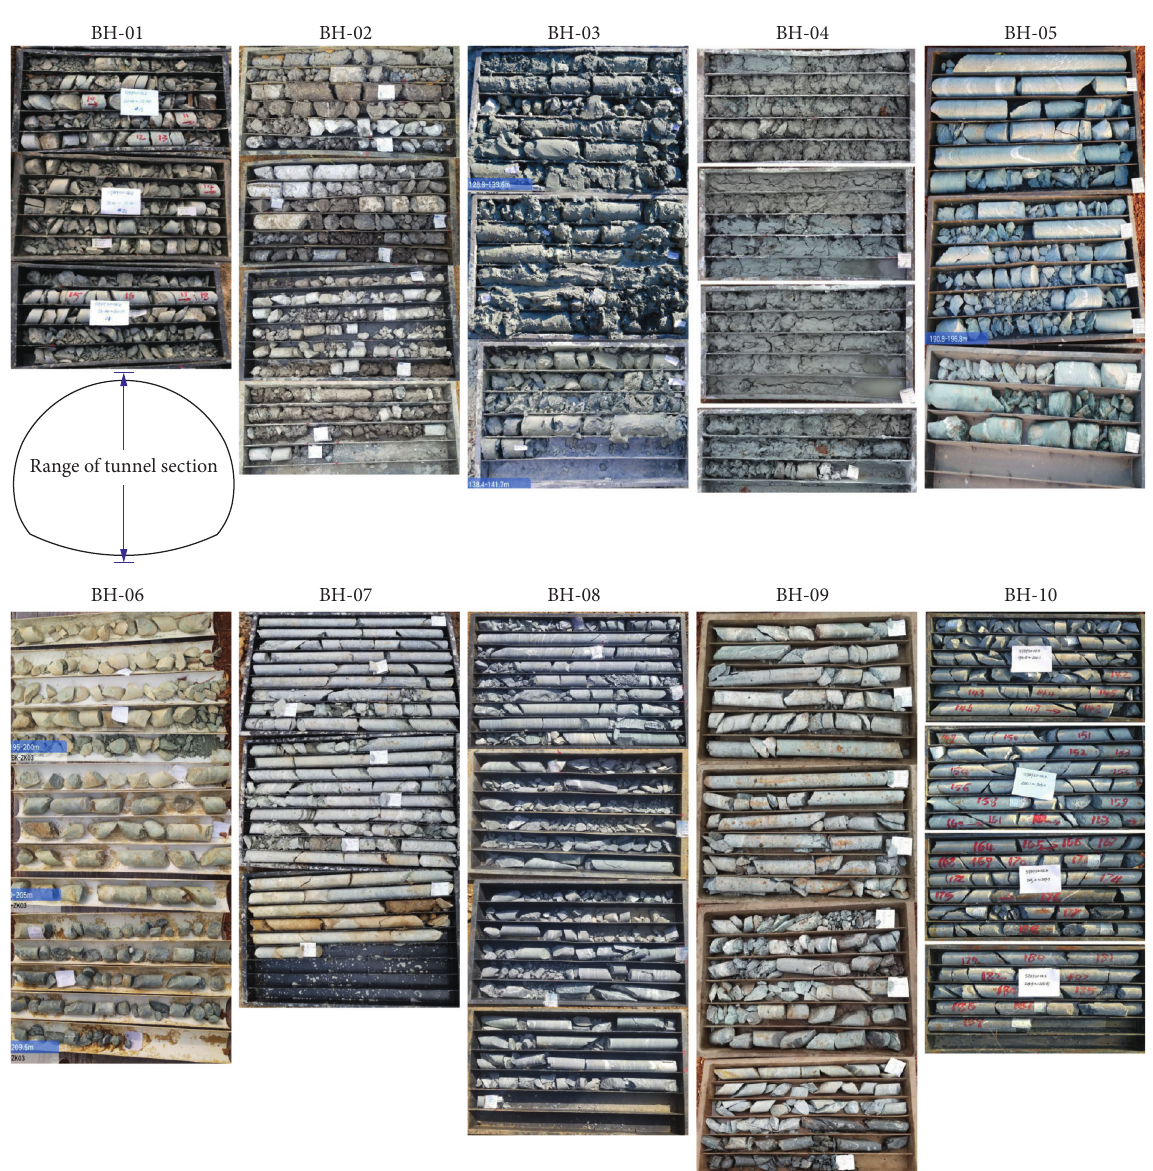
Figure 2: Pictures for the revealed rock mass by boreholes.